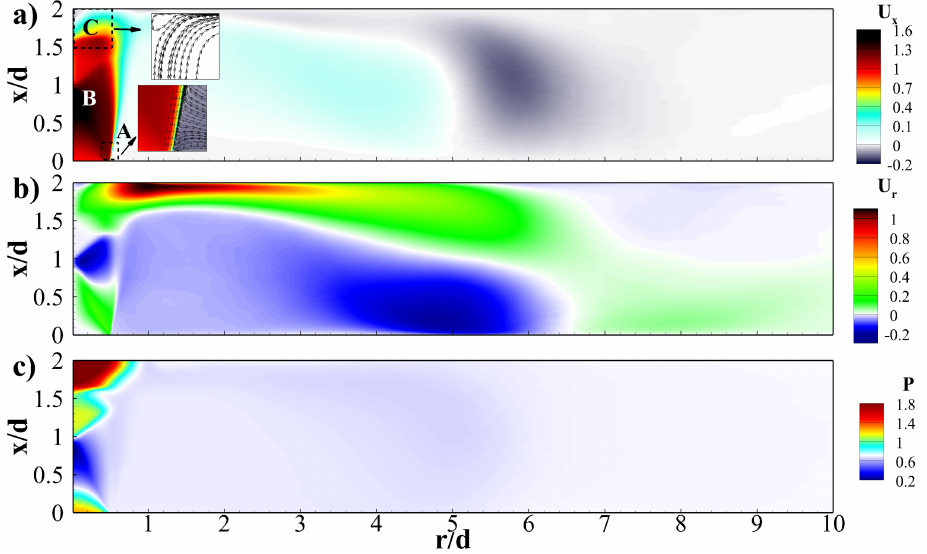
Figure 5. Contours of the mean flow field in the streamwise-radial plane of ( a ) streamwise velocity; ( b ) radial velocity; and ( c )